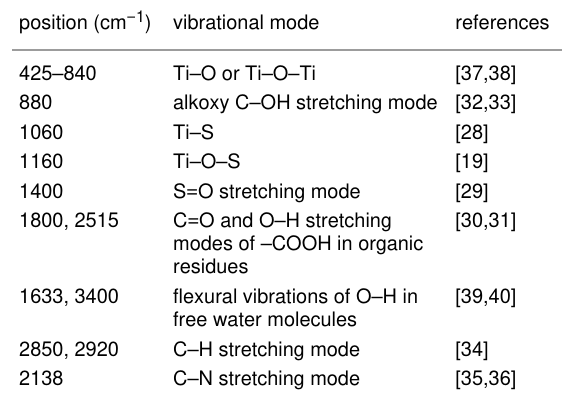
Table 2: Position of the FTIR absorption peaks and the corresponding vibrational modes. position (cm − 1 ) vibrational mode